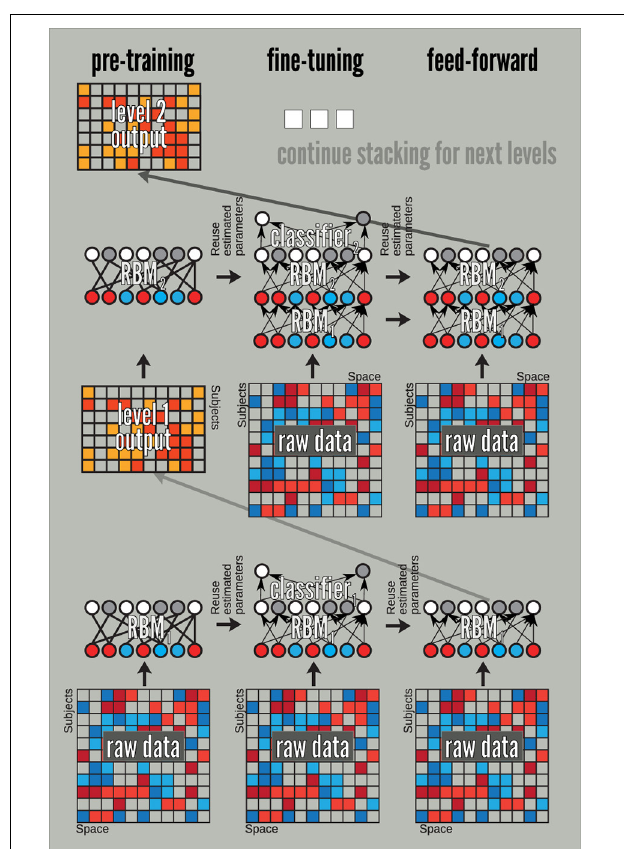
FIGURE 4 | A pre-train/fine-tune sequence for training a DBN. The pre-training stage uses the data from the previous layer, which for our 3-level DBN amounts to raw data (for layer 1), and outputs of the feed-forward mode of the fine-tuned RBMs. The fine-tuning and feed-forward stages always start from the raw data. The fine-tuning stage initializes RBM weights with those learned at the pre-training.